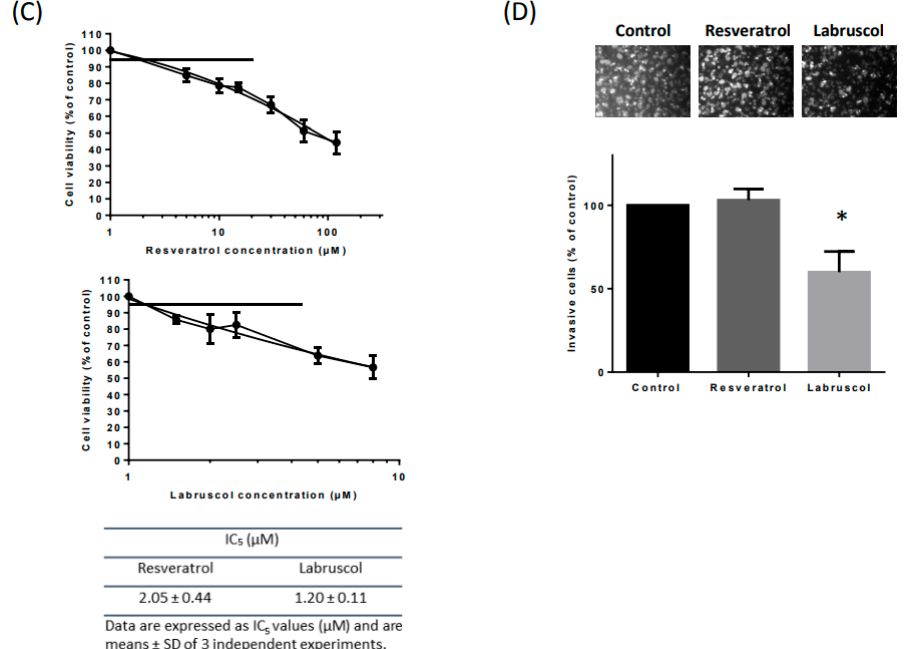
Figure 2. Effects of resveratrol and labruscol on cell viability and cell invasion in HT-144 and HDF cells. ( A ) HT-144 cells were treated with resveratrol and labruscol (0, 25, 50, 100 and 200 μ M) in the presence of fetal bovine serum (FBS) for 24, 48 and 72 h before being subjected to an MTT (3-(4,5-dimethyl thiazol-2yl)-2,5-diphenyltetrazolium bromide) assay for cell viability determination. The values represented the means ± standard deviation (SD) of at least three independent experiments; ( B ) Human dermal fibroblast cells were treated with resveratrol and labruscol (0, 25, 50, 100 and 200 μ M) for 24, 48 and 72 h before being subjected to an MTT assay for cell viability determination. The values represented the means ± SD of at least three independent experiments; ( C ) Determination of the inhibiting concentration (IC 5 values of resveratrol and labruscol. HT-144 cells were treated in a medium without FBS with resveratrol (0, 1.5, 10, 15, 30, 60 and 120 μ M) and labruscol (0, 1.5, 2, 2.5, 5, 8 μ M) for 24 h before being subjected to an MTT assay for IC 5 determination. The values represented the means ± SD of at least three independent experiments. Straight lines correspond to the IC 5 ; ( D ) Determination of cell invasion abilities. Cell invasion was measured using a Boyden chamber for 24 h with a matrigel ® coating (25 μ g/mL). HT-144 cells were treated in an FBS-free medium with vehicle (ethanol), resveratrol (2 μ M) or labruscol (1.2 μ M) for 24 h. The invasion abilities of HT-144 cells were quantified by counting the number of cells that invaded the underside of the transwell, as described in the Material and Methods section. The invasive activity of cancer cells was expressed as the mean number of cells that crossed the matrigel. The values represented the means ± SD of at least three independent experiments. * p < 0.05, compared with the vehicle group.